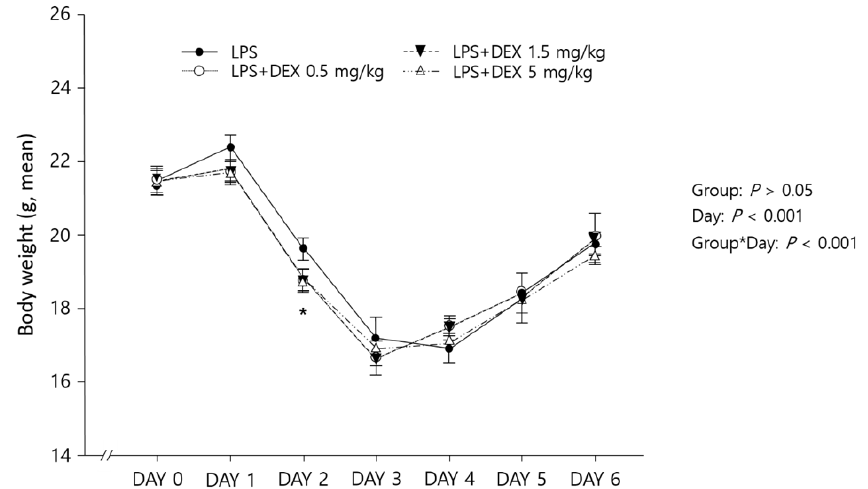
Figure 2. Weight changes in LPS ‐ challenged mice with dexamethasone treatment at different doses (N = 8 per group). Symbols and error bars represent means and standard errors, respectively (* p < 0.05, adjusted p ‐ value by Bonferroni − Holm method).